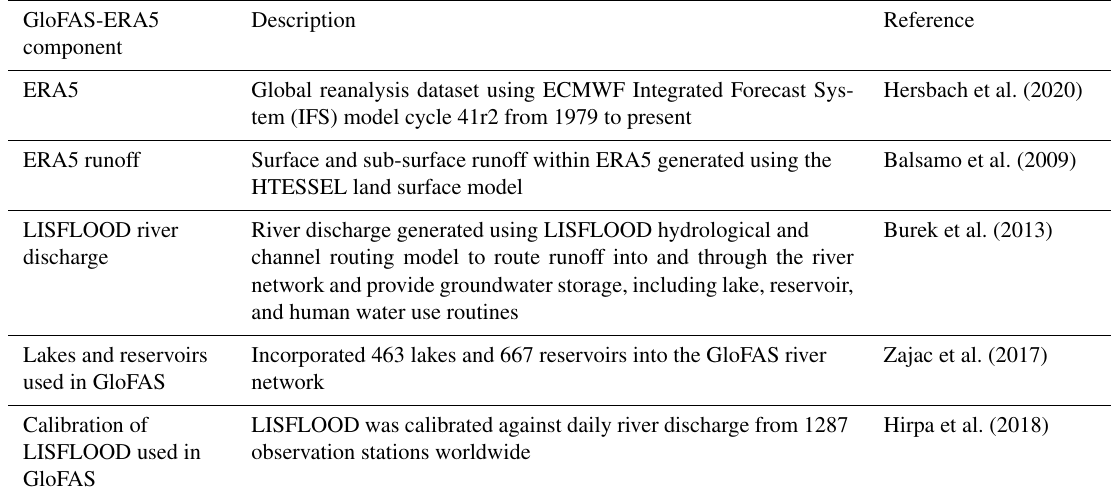
Figure 1. A schematic of the key components in the production of GloFAS-ERA5 v2.1 river discharge reanalysis dataset. Table 1. Scientific papers and model documentation for the key components in the production of GloFAS-ERA5 v2.1 river discharge reanalysis